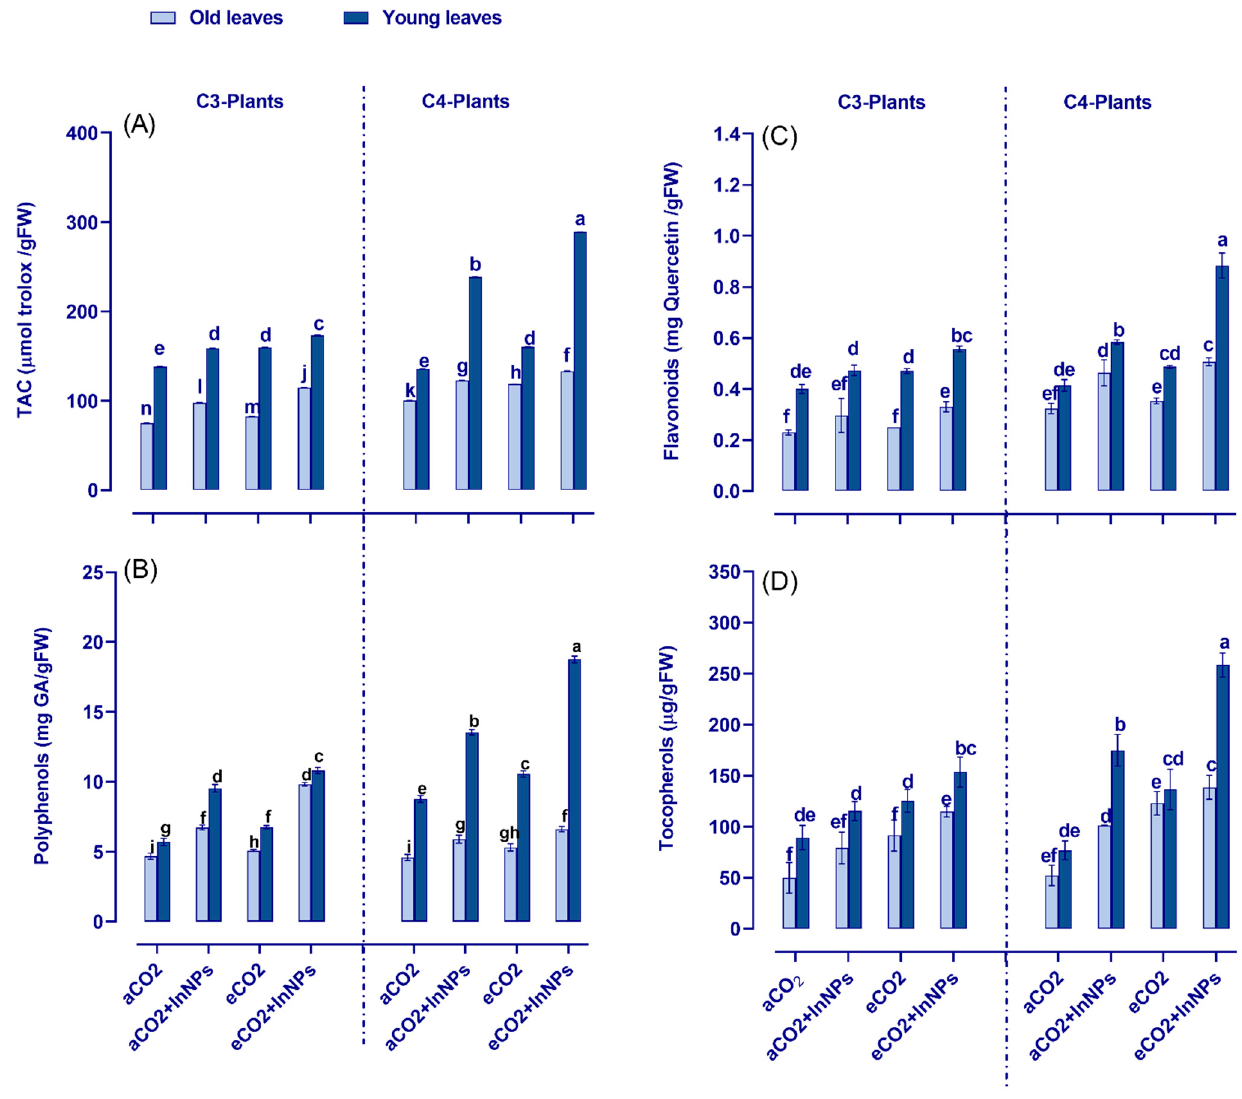
Figure 2. Effect of In 2 O 3 -NPs either alone or in combination with eCO 2 upon ( A ) total antioxidant capacity (TAC) ( B ) polyphenols, ( C ) flavonoids, and ( D ) tocopherols) of both old and young leaves of C3 and C4 plants. Four biological replicates are used to demonstrate each value. The vertical error bar represents the standard error (SE). Fisher’s LSD test ( p < 0.05; n = 4) was used to compare the data for each response separately. Different letters indicate significant differences between means in young and old leaves of C3 or C4 plants.